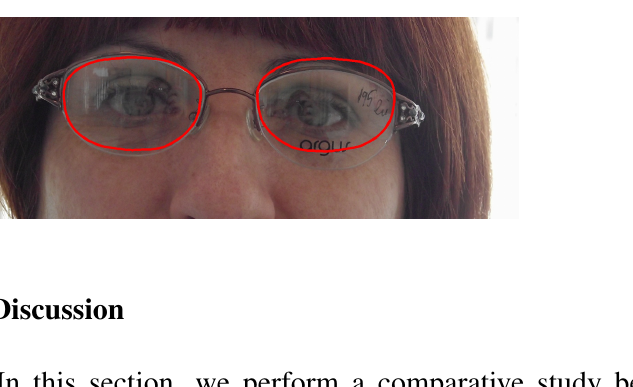
Figure 12. Eyeglasses contour extraction—some failure cases. The lens contours are not accurately extracted from images with little edge